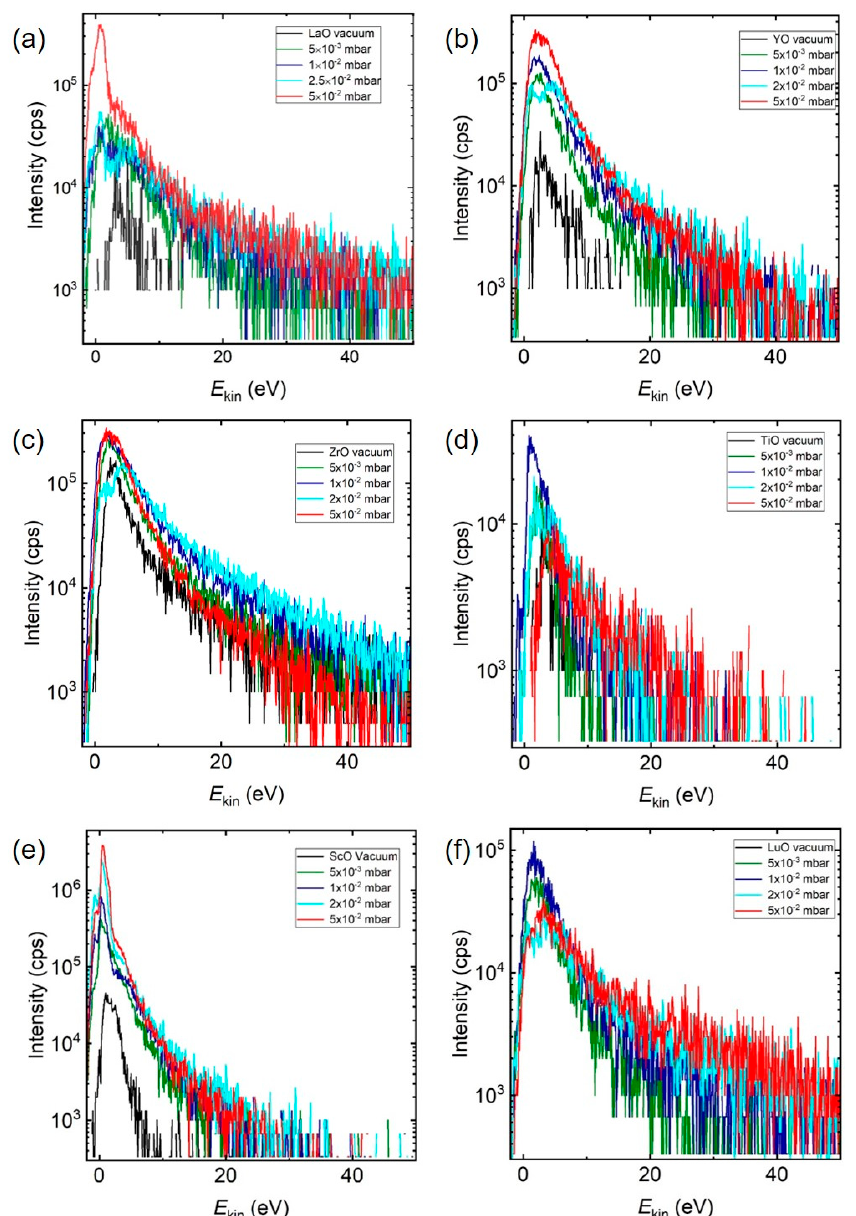
Figure 5. The energy distributions of MO + at different pressures in O 2 for: ( a ) LaO + from the ablation of La 0.33 Ca 0.67 MnO 3 , ( b ) ZrO + , ( c ) YO + from the ablation of 8YSZ, ( d ) ScO + from the ablation of ScMnO 3 , ( e ) TiO + from the ablation of SrTiO 3 , and ( f ) LuO + from the ablation of LuMnO 3 . The ablation conditions are the same for all, with λ = 248 nm and fluence = 2 J/cm 2 .